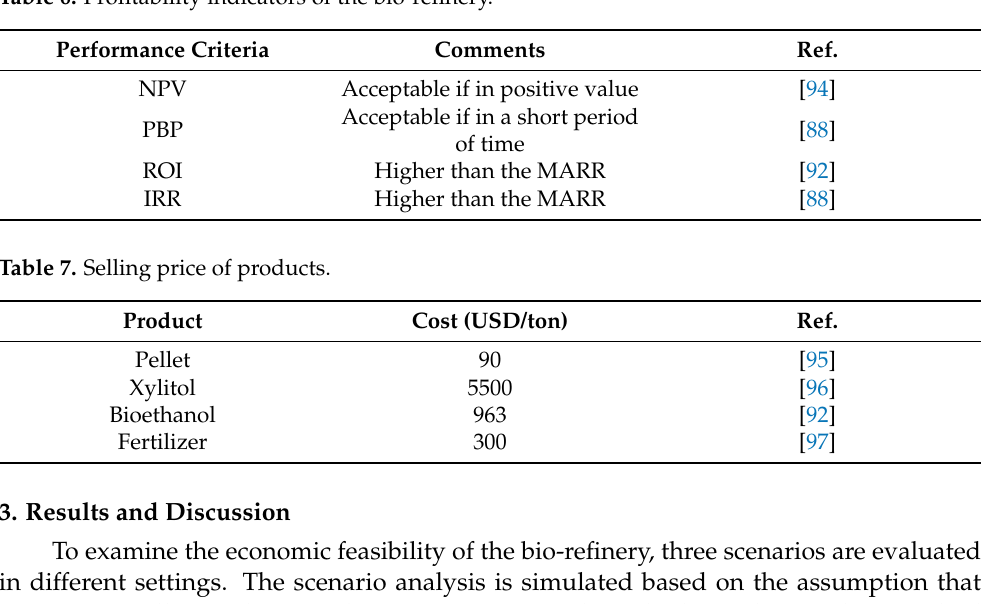
Table 6. Profitability indicators of the bio-refinery.